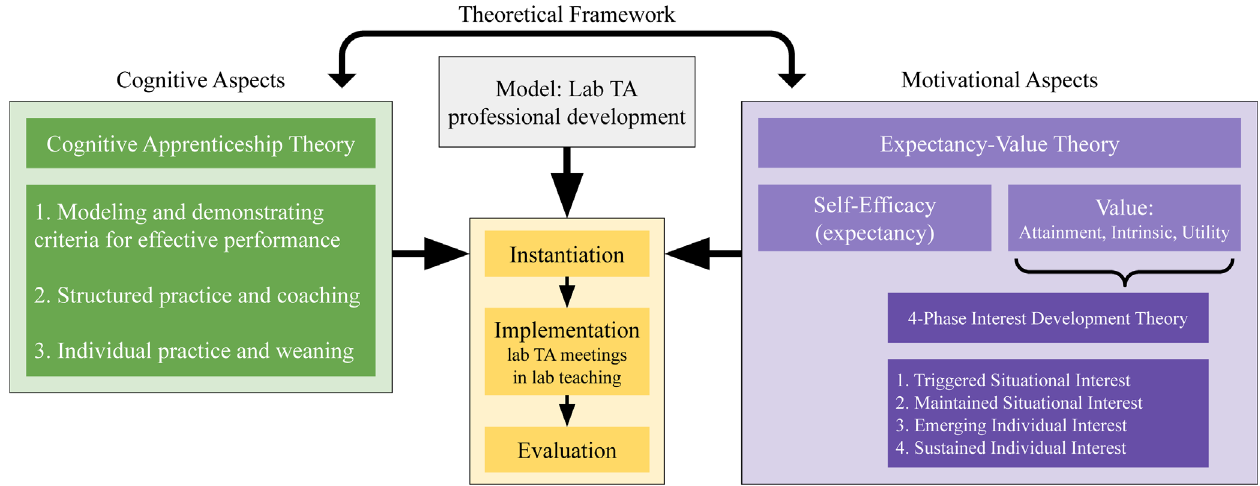
FIG. 1. Framework for this investigation. Cognitive apprenticeship and expectancy-value theories inform the instantiation of our lab TA professional development